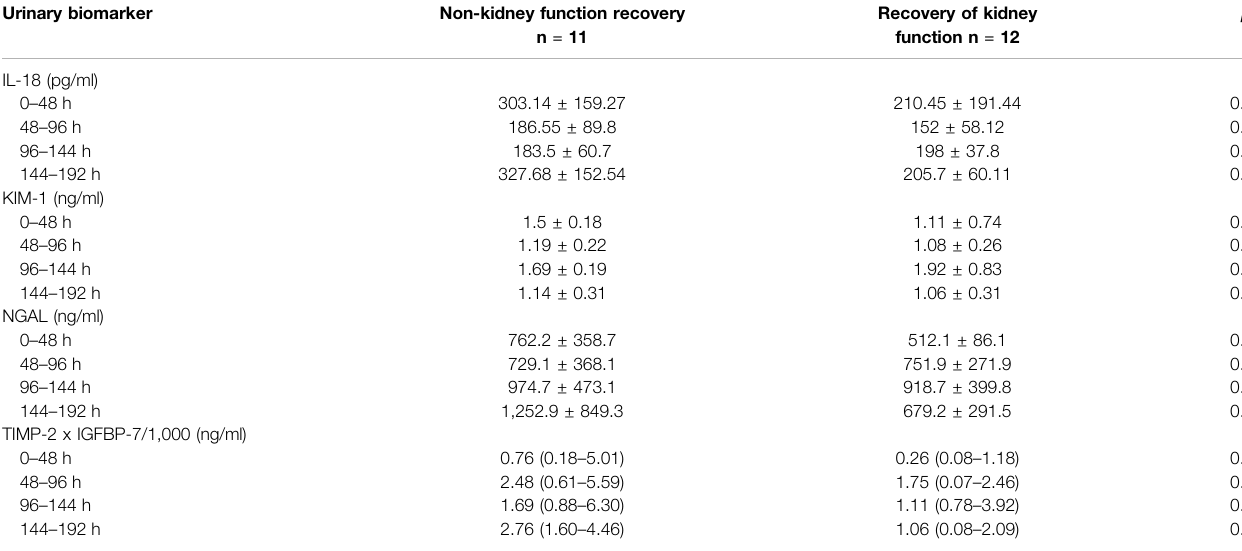
TABLE 6 | Urinary biomarkers value according to the recovery of kidney function at discharge hospital in AKI patients hospitalized in wards and receiving vancomycin. Urinary